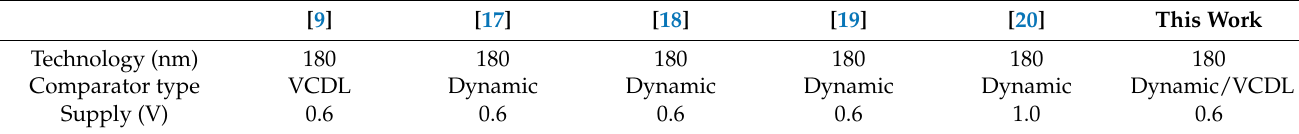
( b ) Figure 16. ( a ) SFDR and SNDR versus input frequency at 400-kS/s sampling rate; ( b ) ENOB trend of the proposed SAR ADC with various input frequencies at 400-kS/s sampling rate. Figure 17. Power breakdown of the proposed SAR ADC. Table 1. Performance summary and comparison. [9]